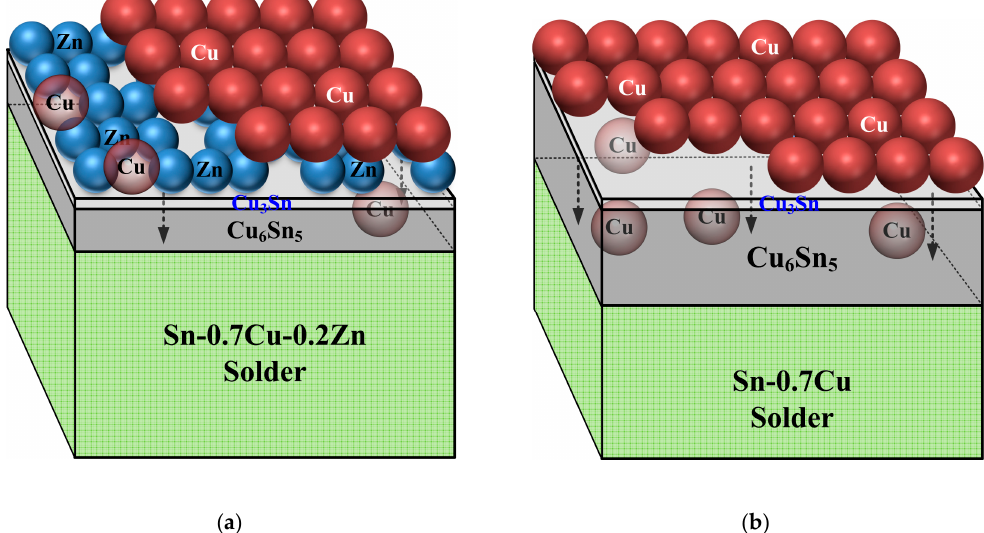
Figure 6. Growth mechanism of Cu 6 Sn 5 IMC at the Cu/solder interface in the ( a ) Sn–0.7Cu–0.2Zn and ( b ) Sn-0.7Cu PV modules.